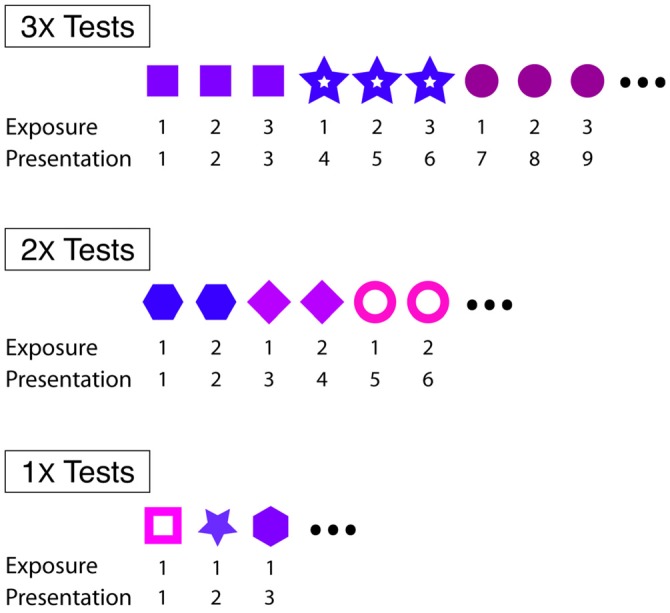
Experimental designs for 3X, 2X and 1X tests. For all tests, males were briefly (<30 s) exposed to individual females at 4–5 min intervals. Within each type of test, different symbols refer to different females.